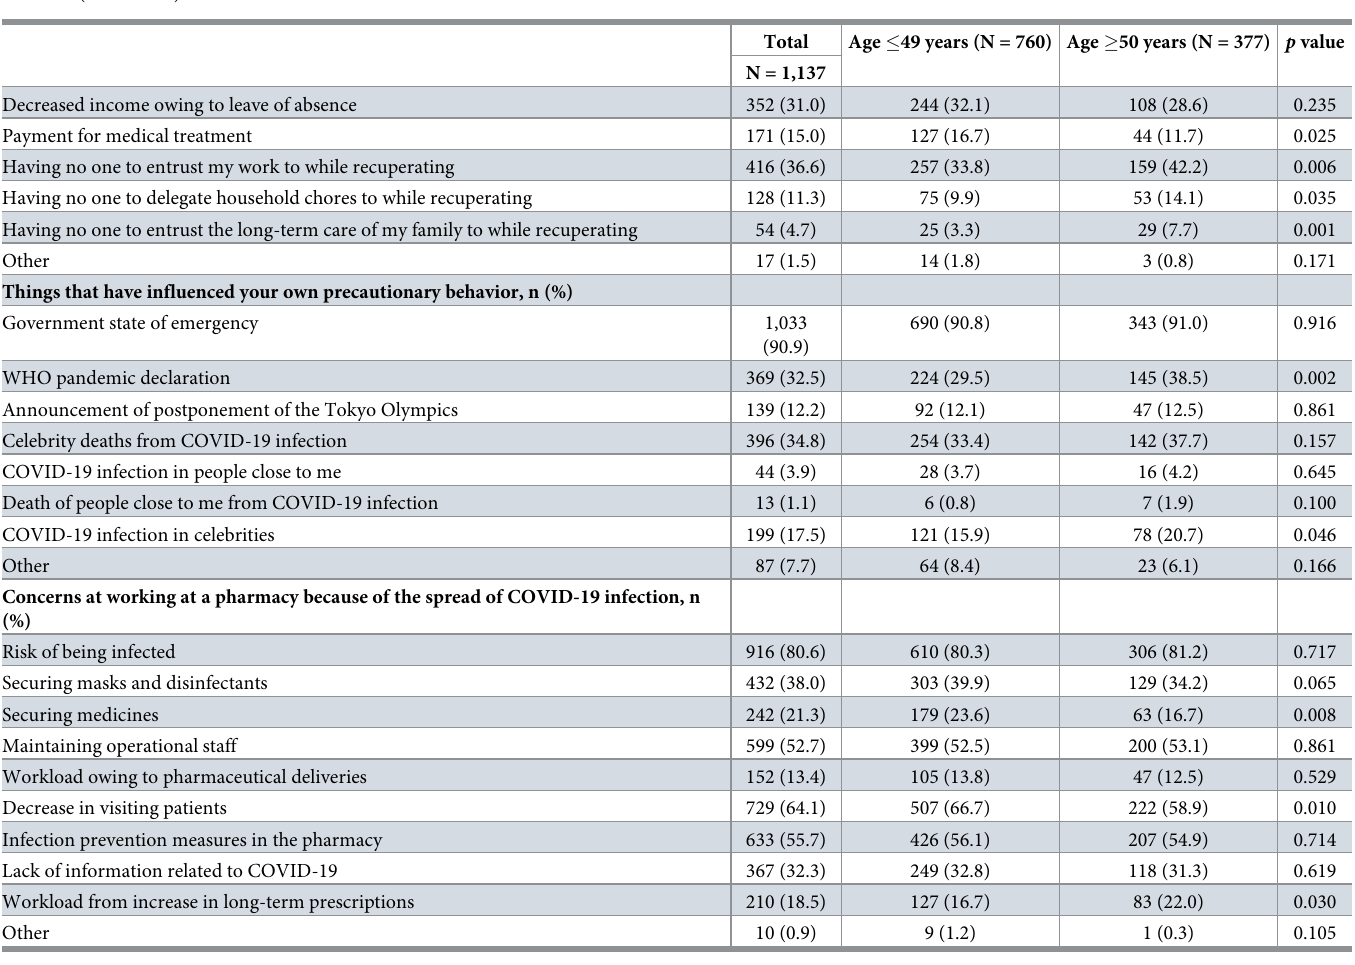
The mean (SD) overall practices score was 5.79 (0.97) out of 10. There were no significant differences in COVID-19-related practice scores between the two age groups. In terms of advice given to pharmacy customers suspected of having COVID-19 infection when they were at home, a high percentage of respondents recommended basic infection control measures, with the top responses being to gargle and wash hands frequently (92.4%), keep infected peo- ple in separate rooms (91.1%), and make sure that everyone wore a mask (87.0%). The two most common responses to the question of what to do if they or their family have symptoms suggesting COVID-19 infection were to call the health center for advice (82.3%) and contact the workplace (77.2%). As for personal COVID-19 infection control measures, nearly all respondents reported that they wear a mask in public (98.8%) and wash their hands regularly using alcohol-based hand sanitizer or soap and water (98.7%). The most common infection control measures taken at pharmacies were thorough hand washing and use of masks by pharmacy staff (97.4%), fol- lowed by ventilating the room regularly